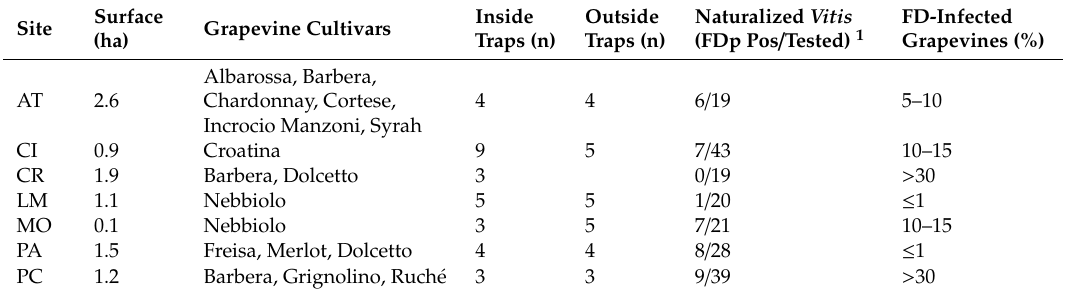
Table 1. Main characteristics of the seven vineyards.